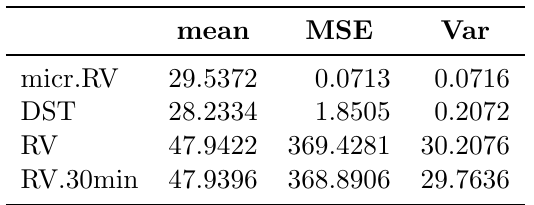
Table 2: Simulation 2. Constant instantaneous volatility and p (1) = − 0 . 32 with noise to signal ratio 0.92. Annualised volatility: 29.5161%.